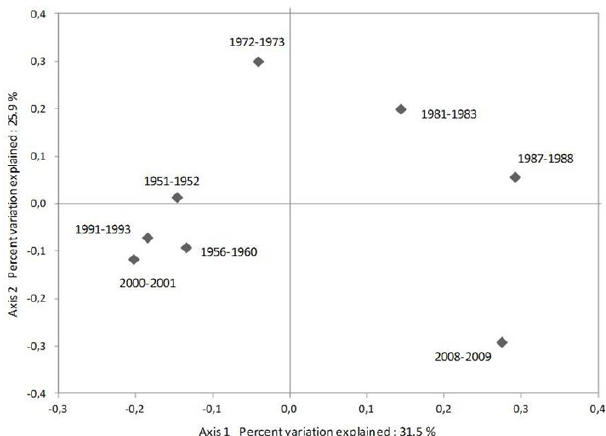
Fig. 5. PCA plot obtained from UNIFRAC analysis comparing the Synechococcus phylogenetic composition (based on the 16S OTUs) of the 8 clone libraries (BF1: 2008–2009, BF3: 2000–2001, BF10: 1991–1993, BF12: 1987–1988, BF15: 1981–1983, BF20: 1972– 1973, BF24: 1956–1960, BF27: